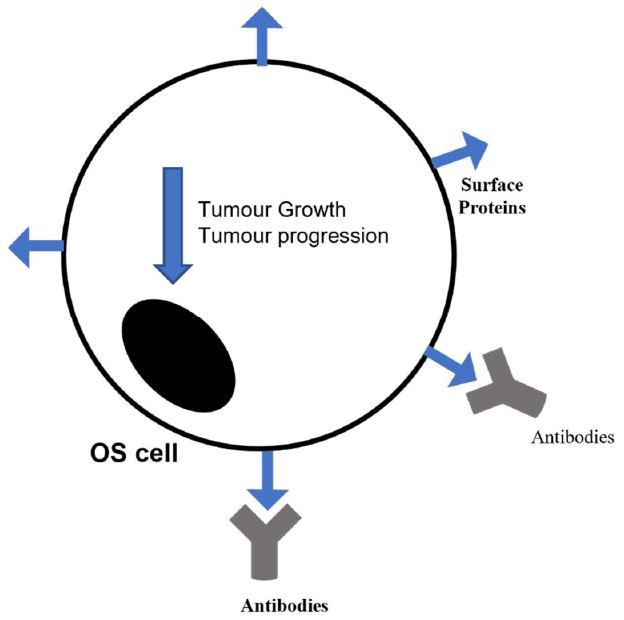
Figure 3. Immunotherapy as an innovative therapeutic approach to counteract cancer development and progression.